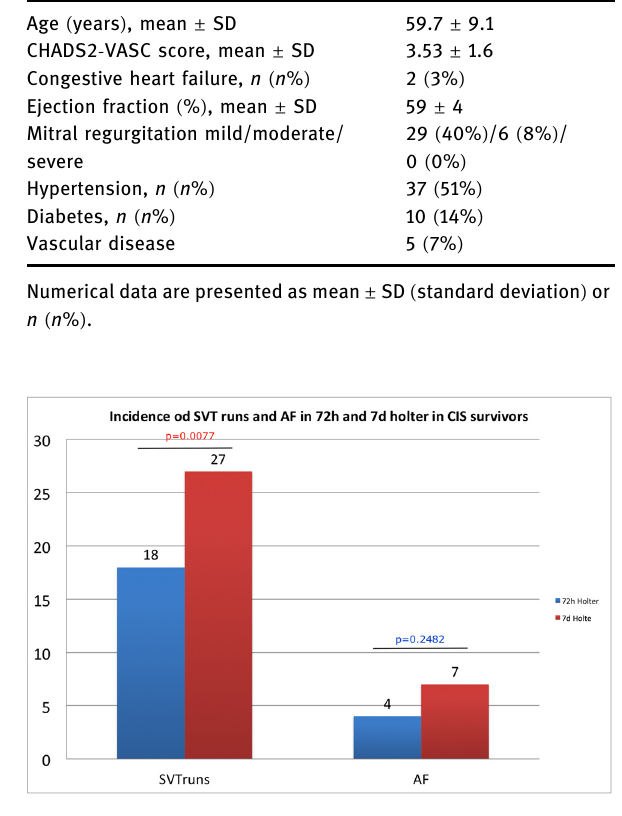
Table 1: Baseline characteristics of the studied group Parameter